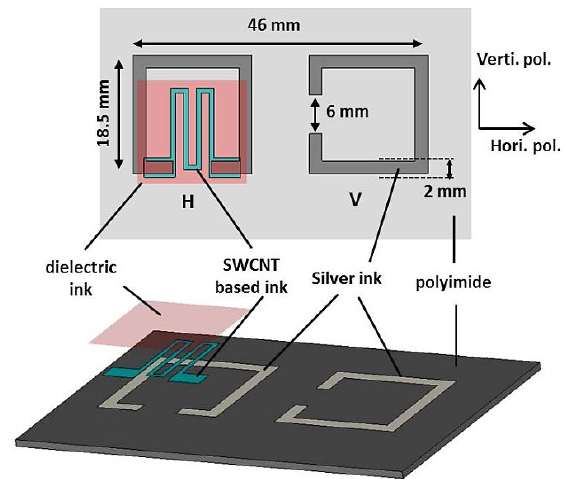
Figure 4. Top view and side view of the fully inkjet-printed dual-polarized sensor device fabricated using three different inks [51].